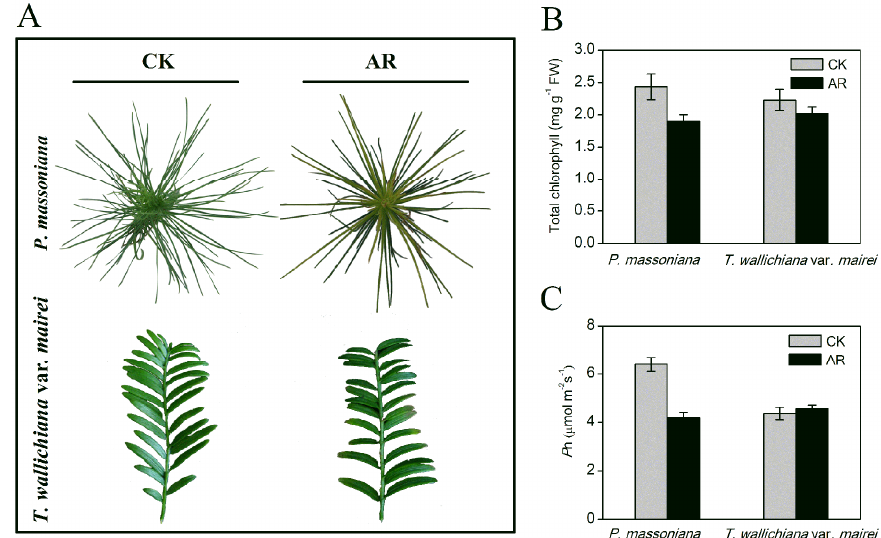
1. Morphological and physiological changes of P. massoniana and T. wallichinana var. mairei under distilled water as control (CK) and simulated acid rain (AR) stress. ( A ) Injury phenotype; ( B ) total chlorophyll content; ( C ) photosynthesis ( P n). Data are means ± SE from measurements of five replicate